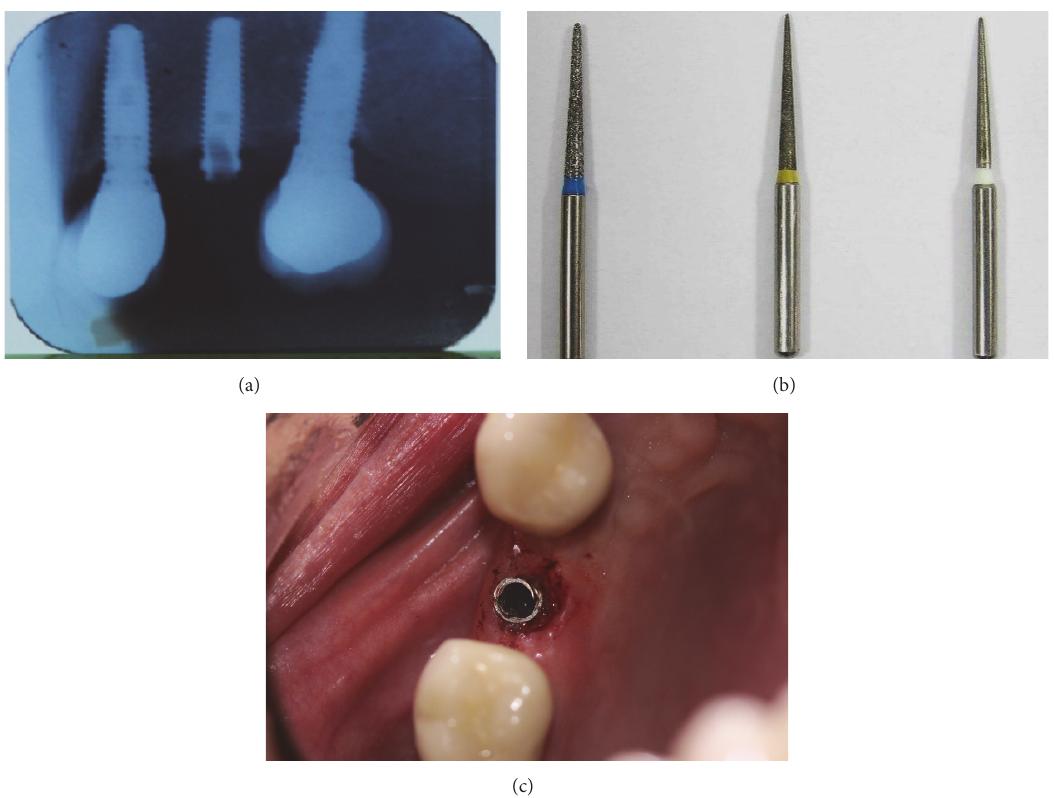
Figure 2: Removal of fracture fragment: (a) radiograph; (b) fissure bur was used to remove the fractured screw; (c) occlusal view.